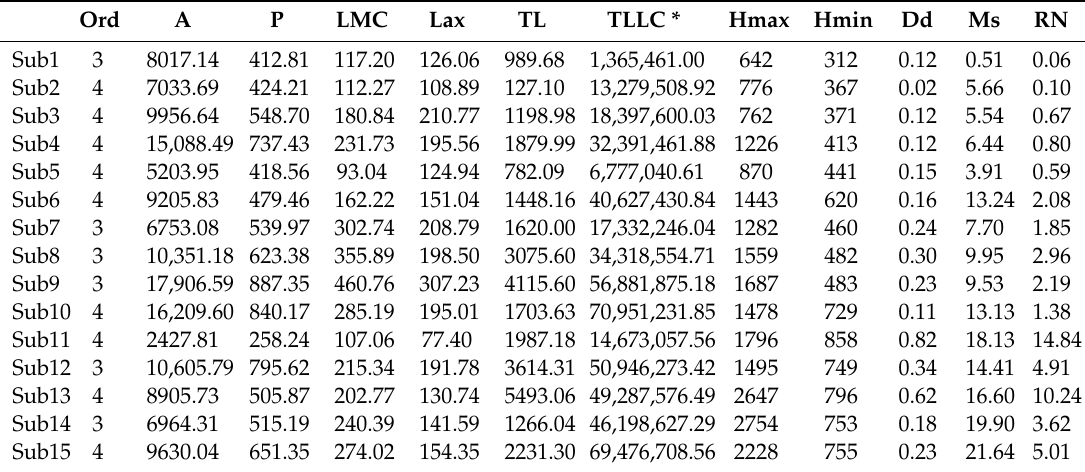
Table 3. Morphometric Rio Grande sub-basin